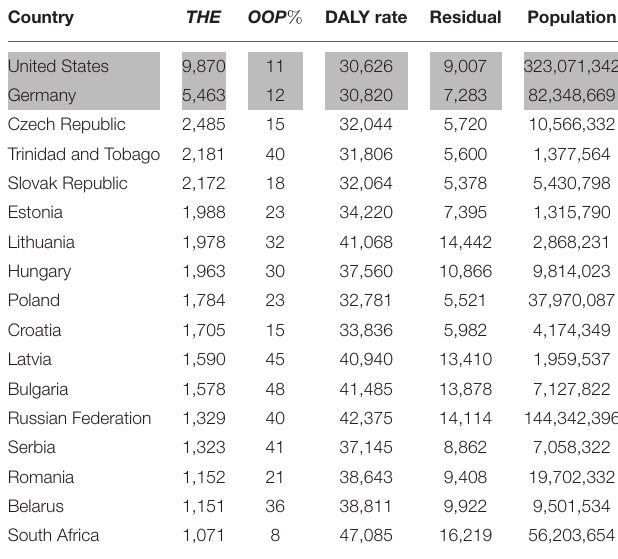
TABLE 5 | Market significant (25% < OOP < 50%) positive outlier countries. Country THE OOP % DALY rate Residual Population